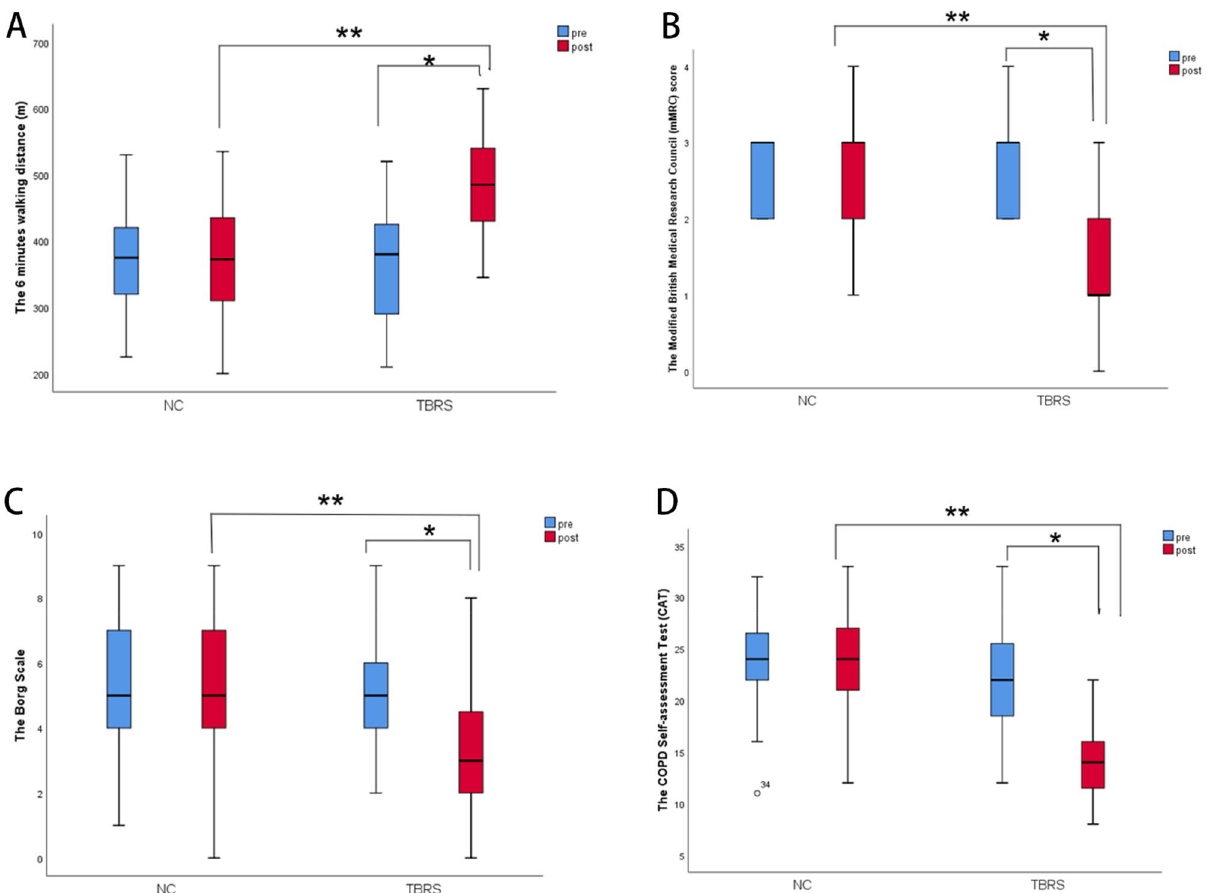
Figure 3. Measurement of pulmonary rehabilitation in the two groups before and after intervention. ( A ) The 6 min walk distance (6MWD); ( B ) the Modified British Medical Research Council (mMRC); ( C ) the Borg scale; ( D ) the COPD Self-assessment Test (CAT); (* P = 0.00 compared with before intervention, ** P = 0.00 compared with the control